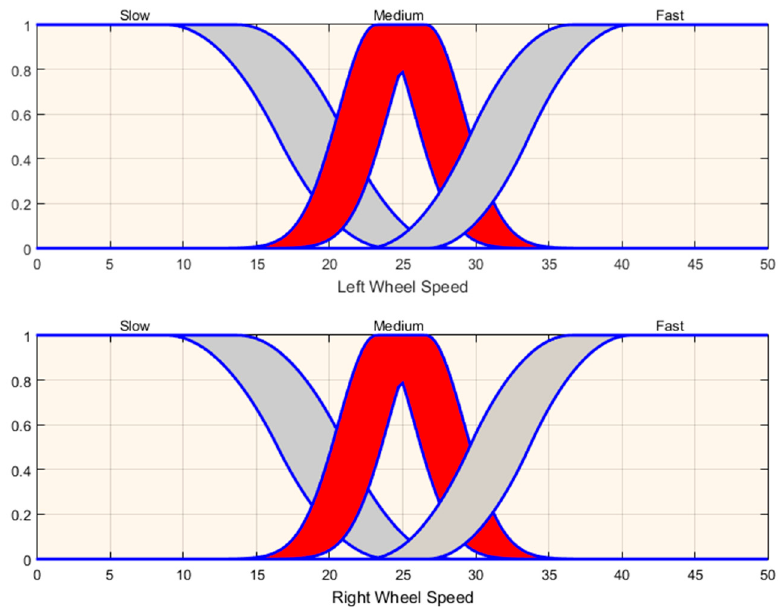
Figure 11. Membership functions of the wheels speed.